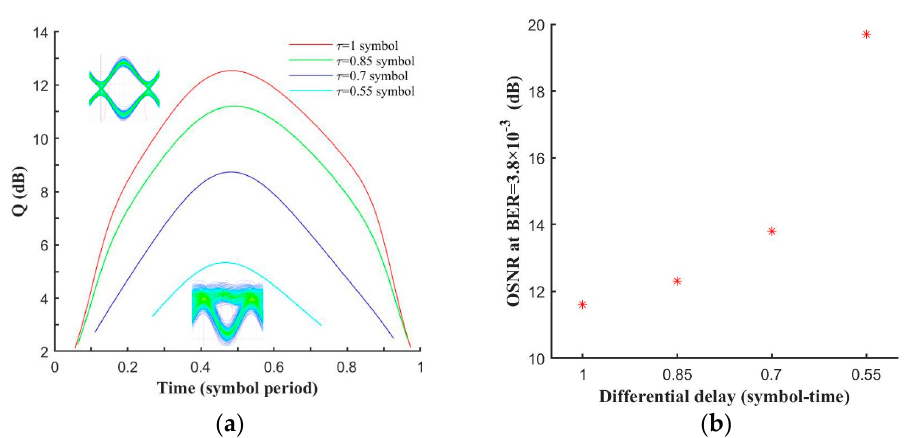
Figure 7. DP-QPSK receiver performance with different delays in a back-to-back configuration: ( a ) Q factor versus DLI differential delay under a given optical signal-to-noise ratio (OSNR) of 15 dB, ( b ) the OSNR required for receivers with different DLI delays at the FEC (Forward Error Correction) threshold of BER = 3.8 × 10 − 3 .